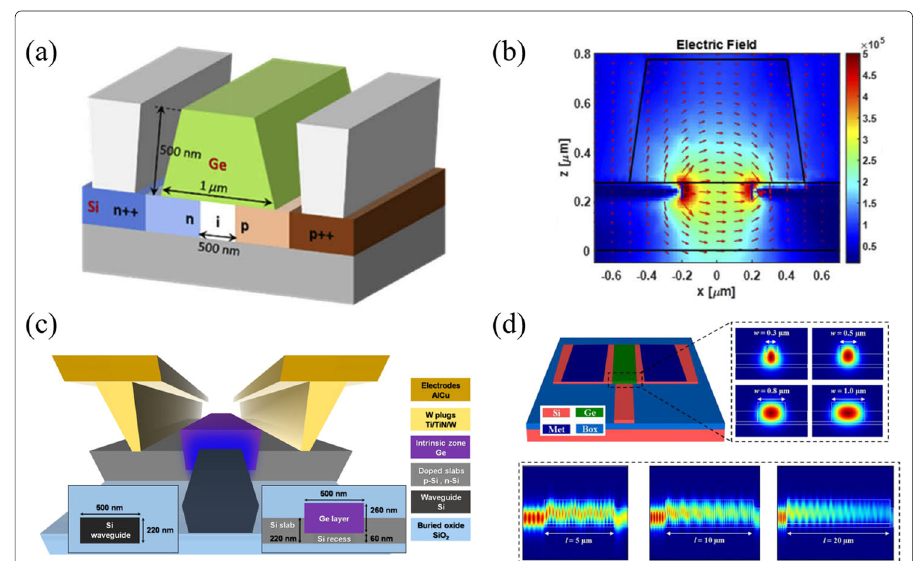
Fig. 11 a Schematic and b electric field distribution of the lateral p-i-n APD with double heterojunctions [79]; c Schematic cross section of the waveguide-coupled Si-Ge p-i-n APD. Insets are cross-sectional views of the p-i-n device and the injection waveguide [80]; d Schematic of the p-i-n APD with lateral p-i-n heterojunctions, optical mode profiles of p-i-n APDs with various germanium widths, and light propagation through p-i-n APDs with various germanium lengths [116]